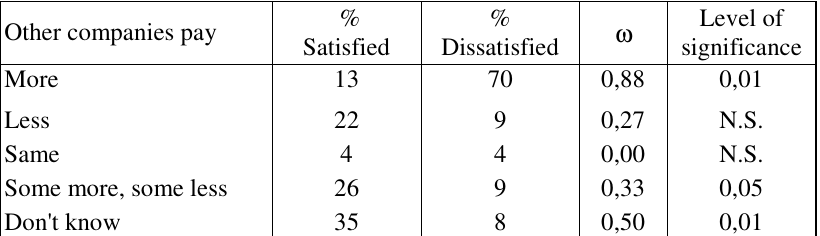
PERCENTAGE RESPONSES OF SATISFIED AND DISSATISFIED \\DRKERS REGARDING WAGES PAID BY OTHER COMPANIES